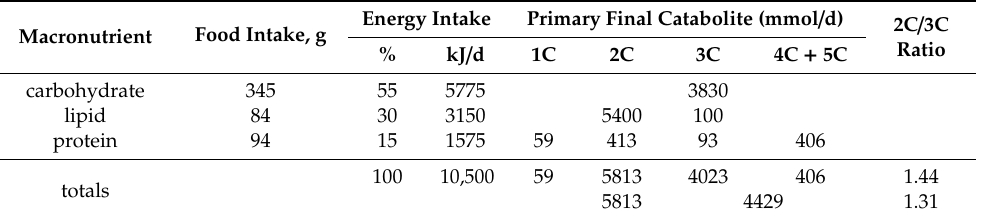
Table 2. Estimation of the 2C / 3C relationships of a human standard